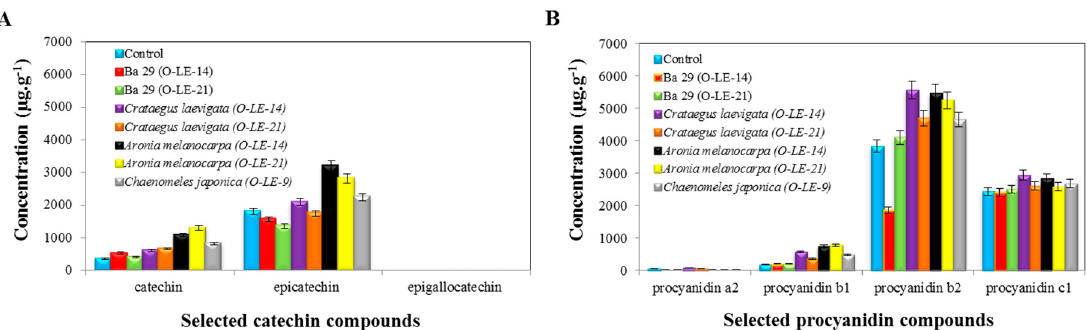
Figure 3. ( A ) Determination of the concentration of selected catechin compounds in the extract from the rootstocks of plants; ( B ) Determination of the concentration of selected procyanidin compounds in the extract from the rootstocks of plants.